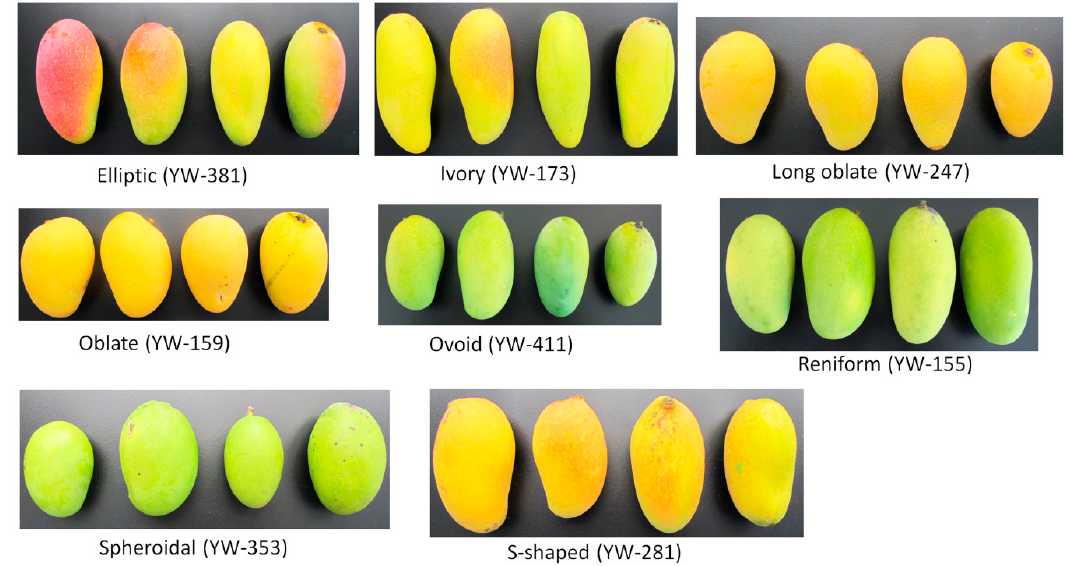
Figure 2. Diversity of the fruit shape within the mango germplasm. Accession name is in brackets.